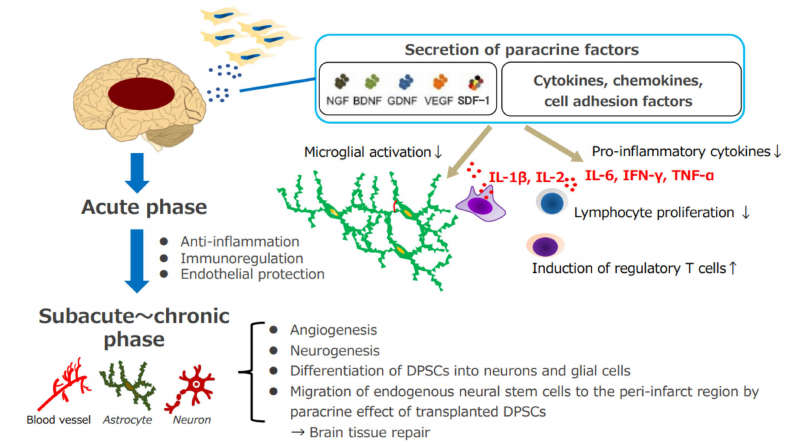
Figure 1. Effect of dental pulp stem cell transplantation in cerebral infarction. Acute phase: (1) direct secretion of stem cells or the accumulation of stem cells in the spleen; paracrine effects of various trophic factors and cytokines via the spleen, (2) the suppression of inflammatory